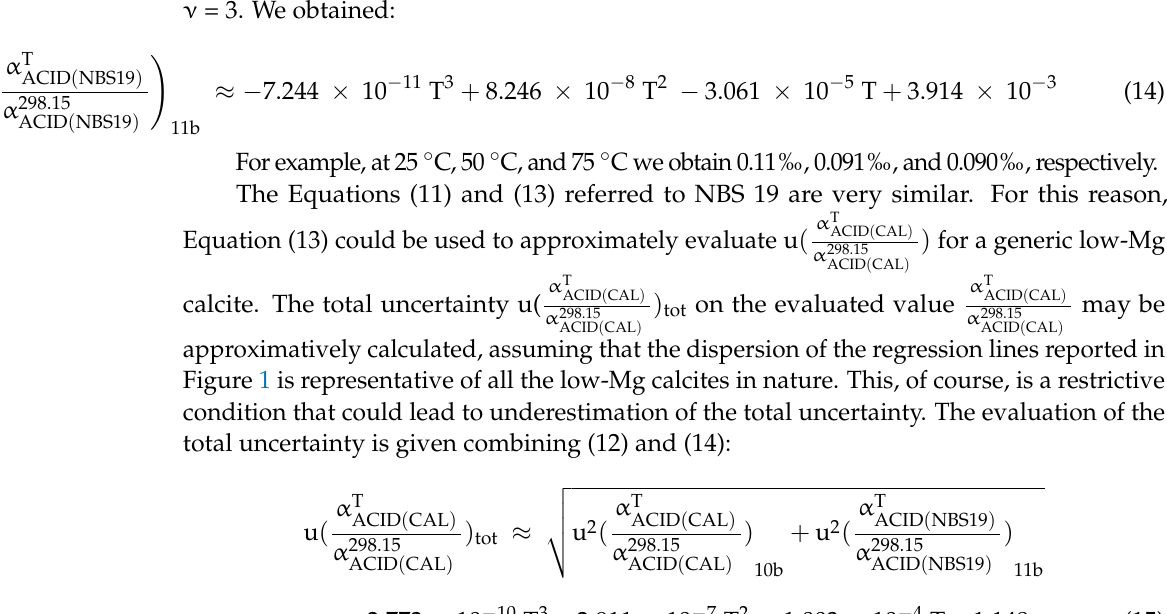
1 ) values used in regression, n = 5, number of 298.15 2 = 0.000068 standard error of regression NBS19